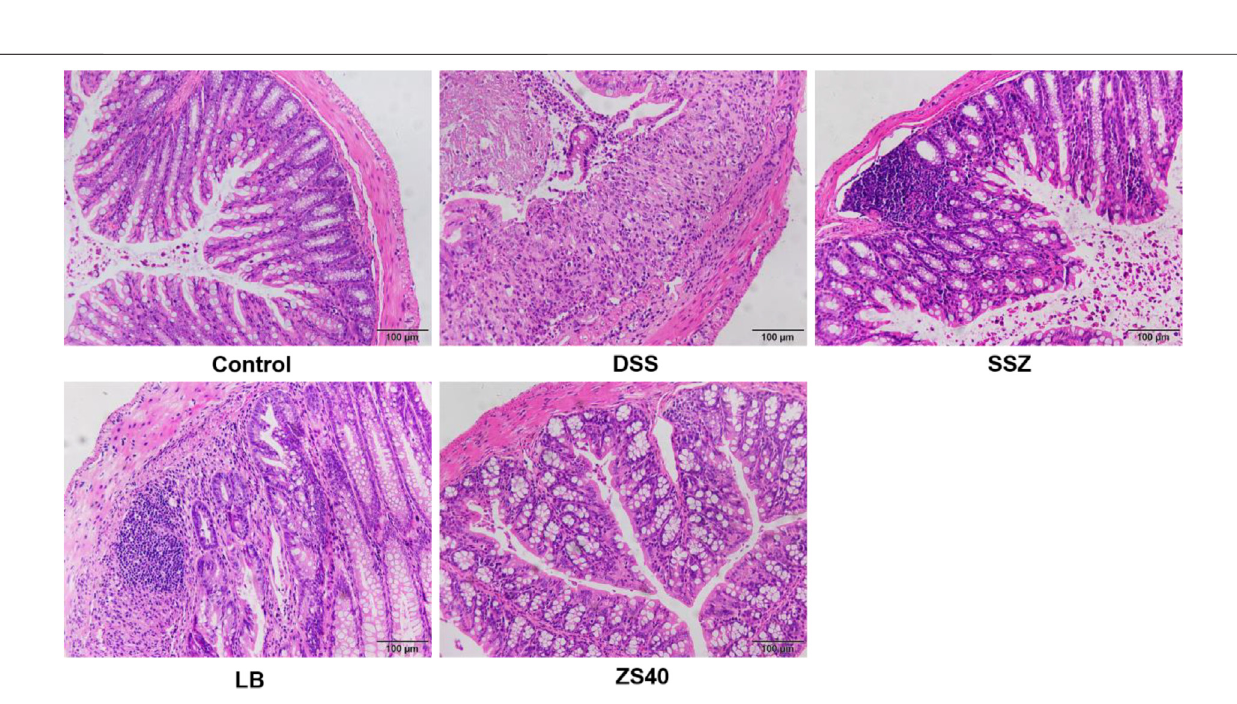
FIGURE 3 | Histopathological observation of colon tissues. Magni fi cation 200 × .The length of the scale bar in each panel is 100 μ m. Control group (cid:2) gavage with saline, DSSgroup (cid:2) 3%dextran sulfate sodium,SSZ group (cid:2) 500 mg/kgbody weight (b.w.) salicylazosulfapyridine treatmentdose, LBgroup (cid:2) 1.0 × 10 9 CFU/kgbody weight (b.w.) Lactobacillus bulgaricus treatment dose, ZS40 group (cid:2) 1.0 × 10 9 CFU/kg body weight (b.w.) L. fermentum ZS40 treatment